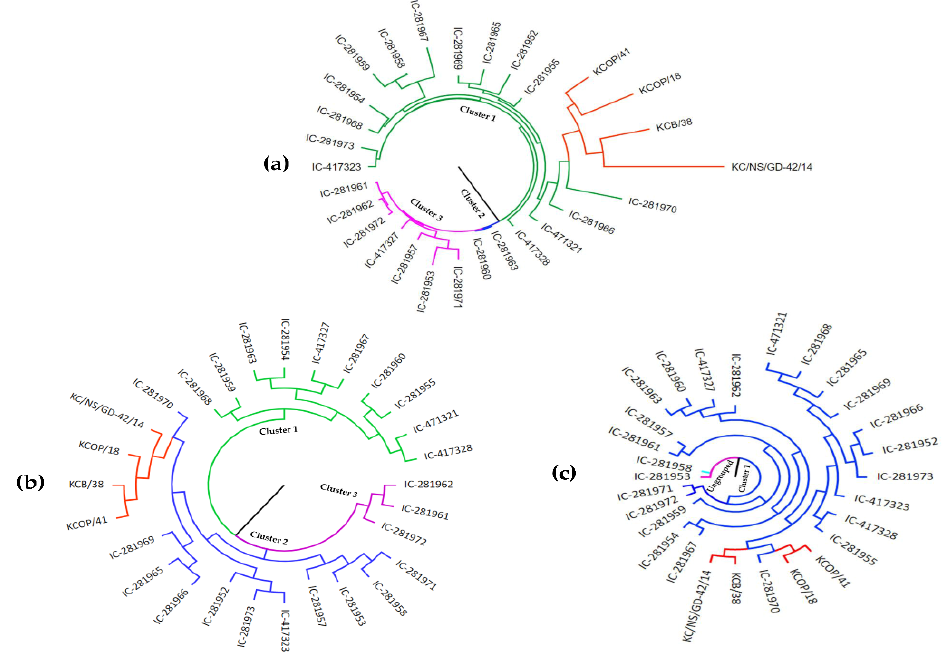
Figure 1. Genetic relationships study among 28 Tinospora accessions based on ( a ) g-SSR, ( b ) EST-SSR, and ( c ) SCoT markers .